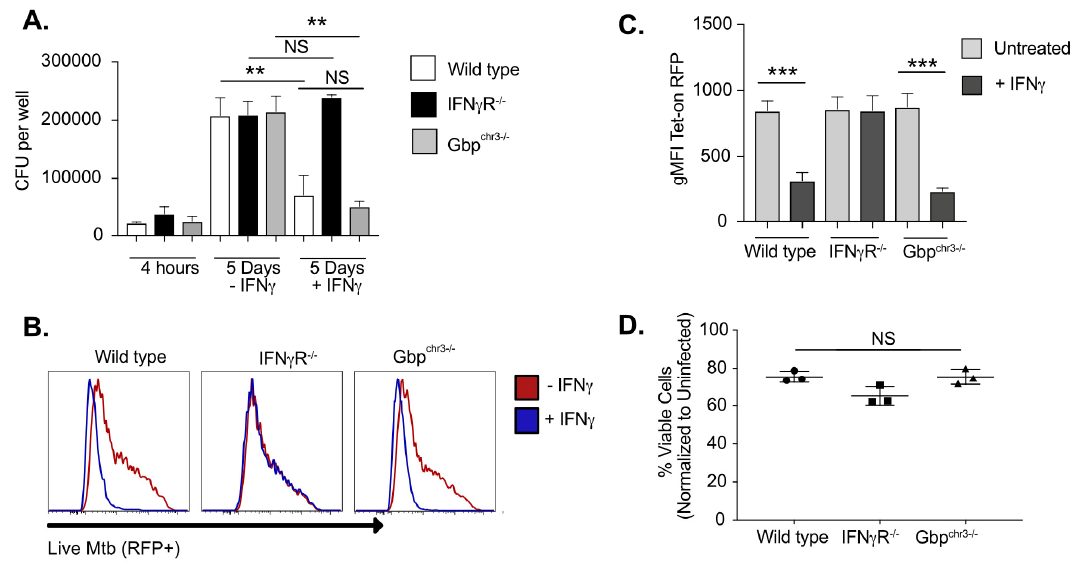
Figure 2. Mycobacterium tuberculosis is resistant to chromosome 3 GBP-mediated control in macrophages. ( A ) BMDMs from wild type, IFN γ R / − or Gbp chr3 − / − mice were infected with M. tuberculosis for 4 h then washed with fresh media in the presence or absence of IFN γ . Five days later the macrophages were lysed, serial dilutions were plated to quantify colony forming units (CFU) of viable M. tuberculosis . Shown is the mean CFU from four biological replicates ± SD ** p < 0.01; NS is not significant. Data are representative of five independent experiments. ( B , C ) BMDMs from wild type, IFN γ R / − or Gbp chr3 − / − mice were infected with the live/dead reporter M. tuberculosis for 4 h then washed with fresh media in the presence or absence of IFN γ . Four days later aTc was added to each well at a final concentration of 500 ng/mL. The following day infected cells were lifted and the fluorescence intensity of the inducible Tet-on TagRFP was determined by flow cytometry. Cells were gated on live and infected (mEmerald+) cells. ( B ) A representative histogram of tagRFP fluorescence is shown. ( C ) Shown is the mean fluorescence intensity of tagRFP for three biological replicates. ( D ) Cell viability was quantified from Mtb infected cells and normalized to uninfected cells a day five. These data are representative of three independent experiments. *** p < 0.001. To ensure that the relatively insensitive CFU-based intracellular growth assay did not mask subtle effects of GBP expression on bacterial fitness, we used a fluorescent live/dead reporter as an orthologous method to measure Mtb intracellular viability by flow cytometry. This reporter expresses a constitutive mEmerald and an anhydrotetracycline (aTc)-inducible tagRFP. BMDMs from wild type, IFN γ R − / − and Gbp chr3 − / − mice were infected with the Live/Dead Mtb reporter and left untreated or were stimulated with IFN γ . Four days later aTc was added to induce tagRFP expression in viable intracellular bacteria. The following day, cells were analyzed by flow cytometry and the mean fluorescence intensity (MFI) of tagRFP in infected mEmerald+ cells was quantified Figure 2B,C. Similar to the CFU analysis, IFN γ activation reduced the intensity of tagRFP to a similar extent in both wild type and Gbp chr3 − / − BMDMs, and this reduction depended on the IFN γ receptor. We further quantified cell viability in all genotypes and observed no significant differences between wild type and Gbp chr3 − / − BMDMs five days following infection Figure 2D. Thus, we were not able to detect a role for the chromosome 3 GBP cluster in the IFN γ mediated restriction of virulent Mtb in